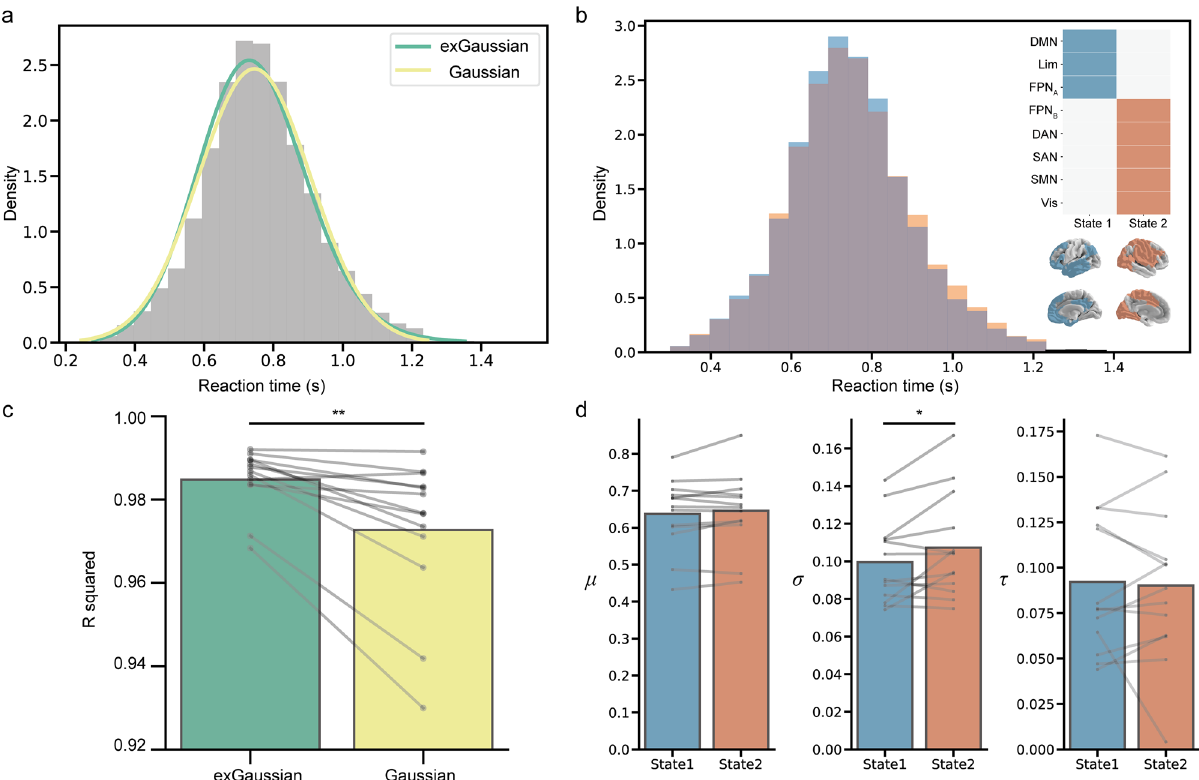
Figure 3. Results summary in Dataset2. ( a ) RT histogram and fitting result. ( b ) RT histograms in each brain state. Individual state is represented by an activity pattern in which each brain region is active (blue and red) or inactive (white). ( c ) R squared values for exGaussian and Gaussian distributions for each individual. ( d ) exGaussian parameters differences between brain states for each individual. * p < 0.05, ** p < 0.005. DMN: default mode network; Lim: limbic; FPN: frontoparietal network; DAN: dorsal attention network; SAN: salience network; SMN: somatomotor network; Vis: visual.